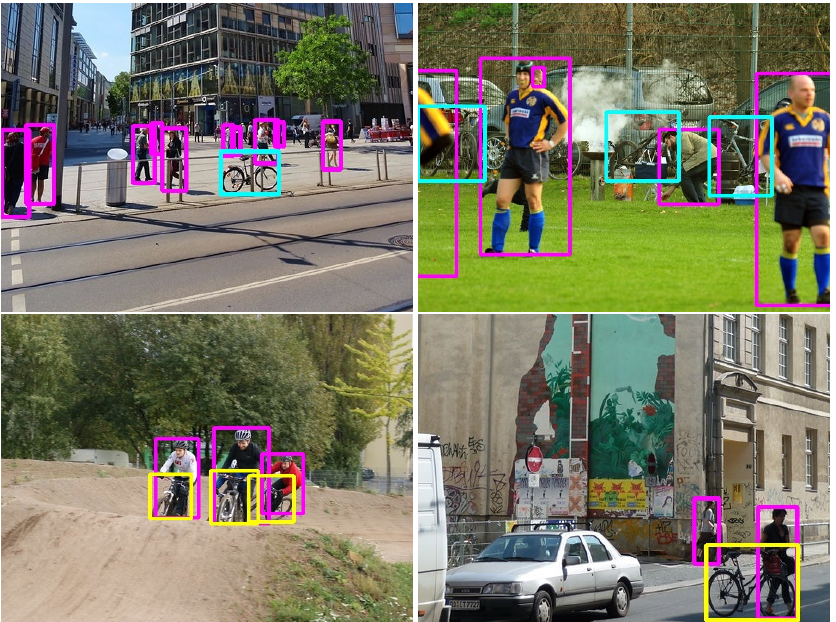
Figure 3. Examples of correctly identified stationary (top, cyan boxes) and moving (bottom, yellow boxes) bicycles, with all detected persons marked in magenta